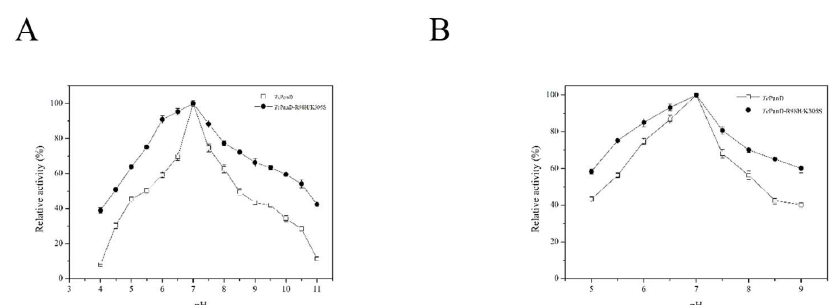
Figure 5. E ff ect of pH on TcPanD and TcPanD-R98H / K305S ( A ) and pH stability ( B ). A, The optimal Figure 5. Effect of pH on TcPanD and TcPanD-R98H/K305S ( A ) and pH stability ( B ). A, The optimal